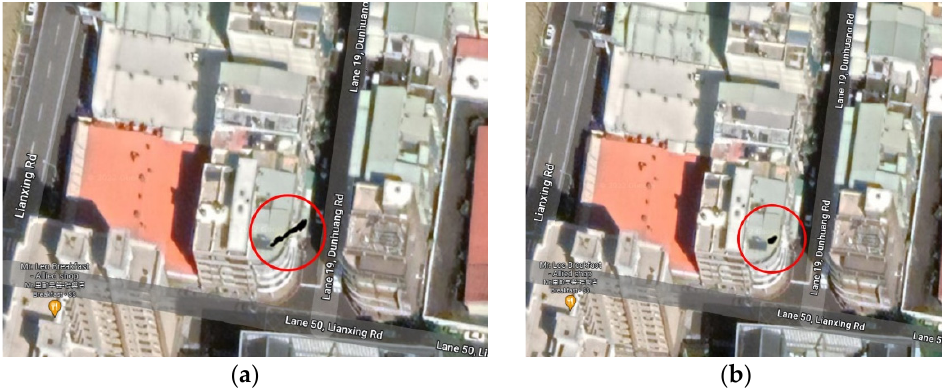
Figure 29. GPS value test chart of a stopped vehicle: ( a ) current situation of GPS value drift; ( b ) current status of GPS value drift improved.